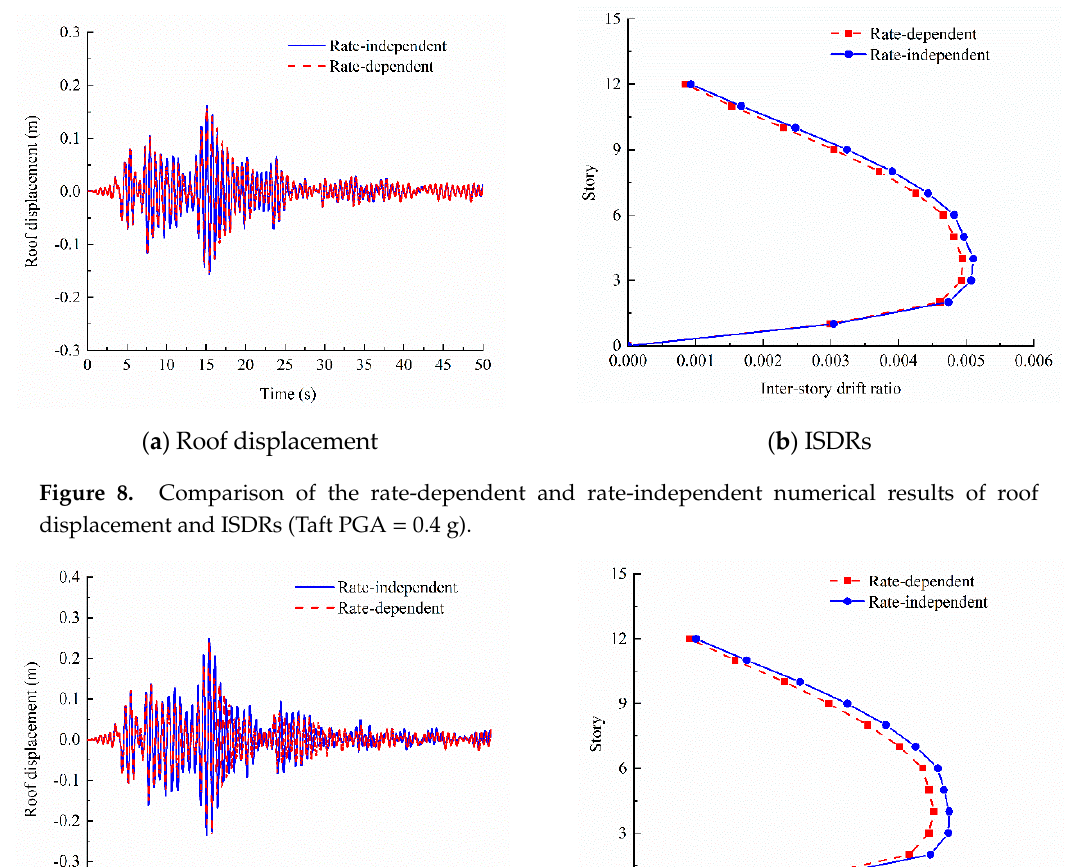
Figure 7. Comparison of the rate-dependent and rate-independent numerical results of roof displacement and an inter-story drift ratio (Taft PGA = 0.2 g).